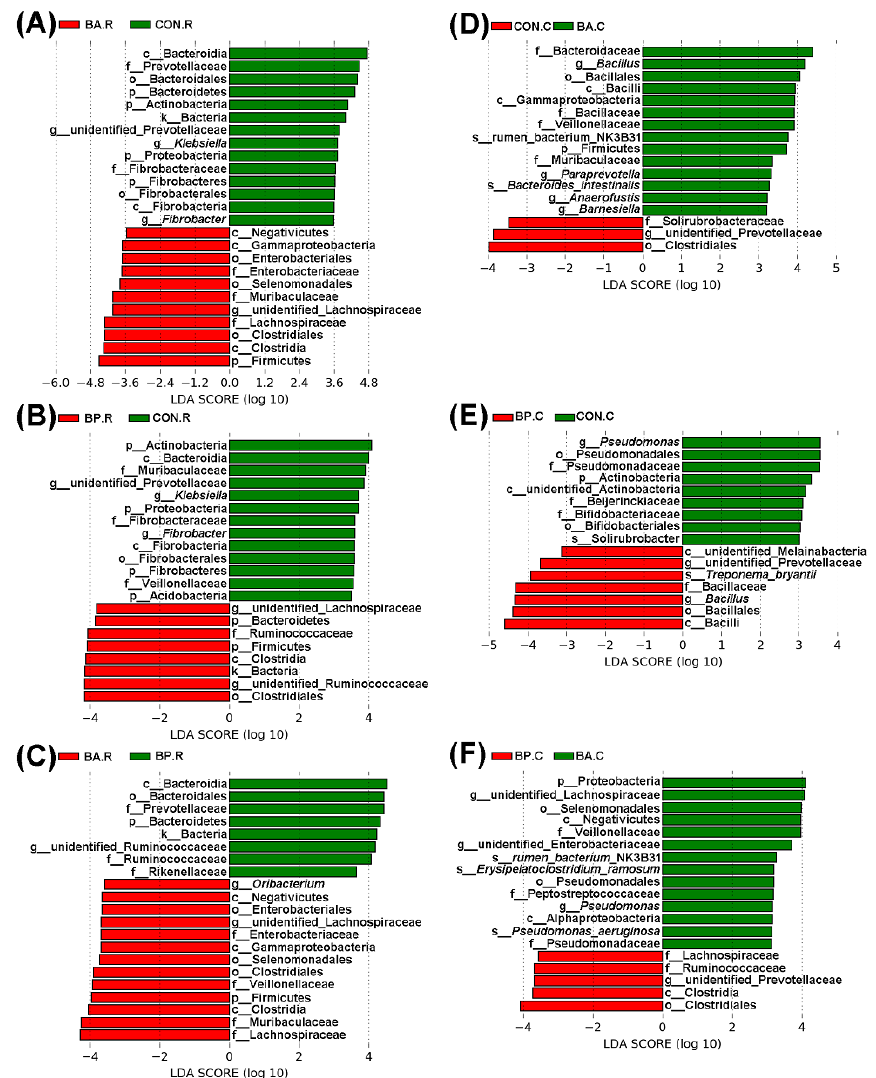
Figure 5. The LDA (Linear Discriminant Analysis) at the genus level. Utilizing linear discriminant analysis coupled with effect size (LEfSe), bacterial taxa at the genus level were identified significantly through the default parameters between the control and BA groups ( A and D ), between the control and BP groups ( B and E ), and between the BA and BP groups ( C and F ), respectively. Only the genera with a significant linear discriminant analysis threshold >3.5 ( A , B , and C ) or >3 ( D , E , and F ) are shown. BA.R, BP.R, and CON.R indicate rumen content samples of BA-treated, BP-treated, and control groups, respectively; BA.C, BP.C, and CON.C indicate caecum feces samples of BA-treated, BP-treated, and control groups, respectively.